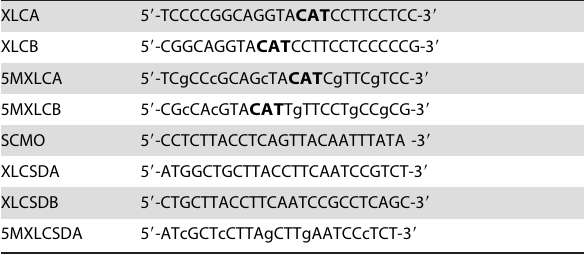
X.laevisCRIM1 Morpholino Oligonucleotide Sequences: XLCA